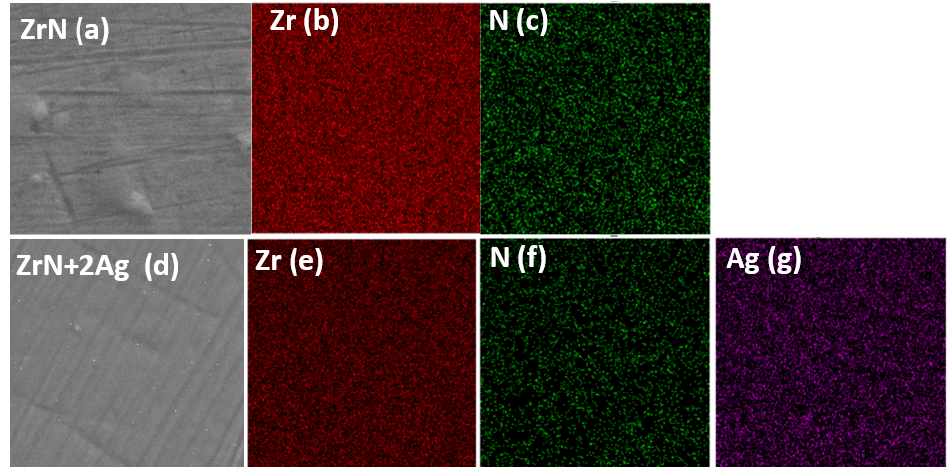
Figure 5. Surface morphology of ( a ) ZrN and ( d ) ZrN+2Ag coatings. EDS mapping of ( b ) Zr and ( c ) N and ( e ) Zr, ( f ) N and ( g ) Ag for the surface of the ZrN and ZrN+2Ag coatings, respectively.